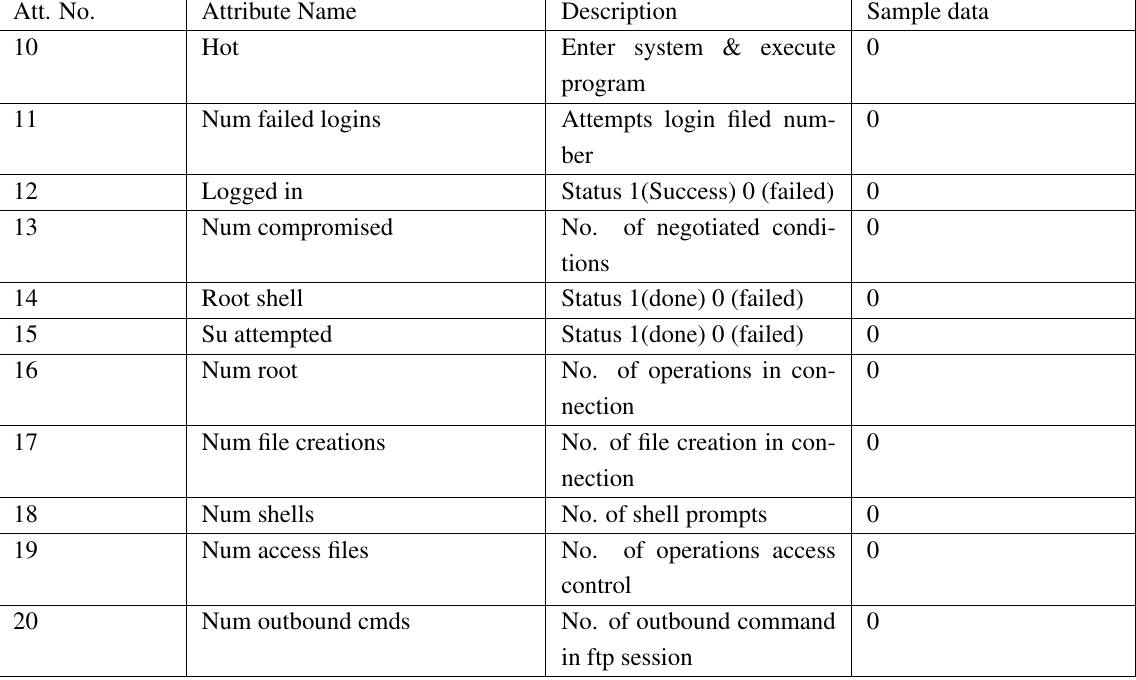
Table 2. Content related features of each network connection vector Att.